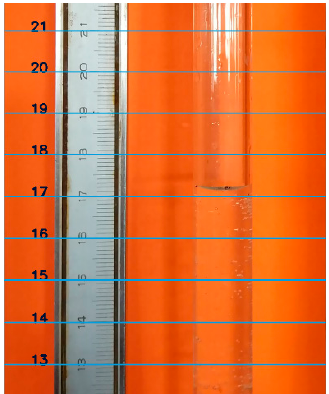
Figure 11. Recognition results for the 1 cm calibration line (right rotation 90 degrees). Appl. Sci. 2020 , 10 , x